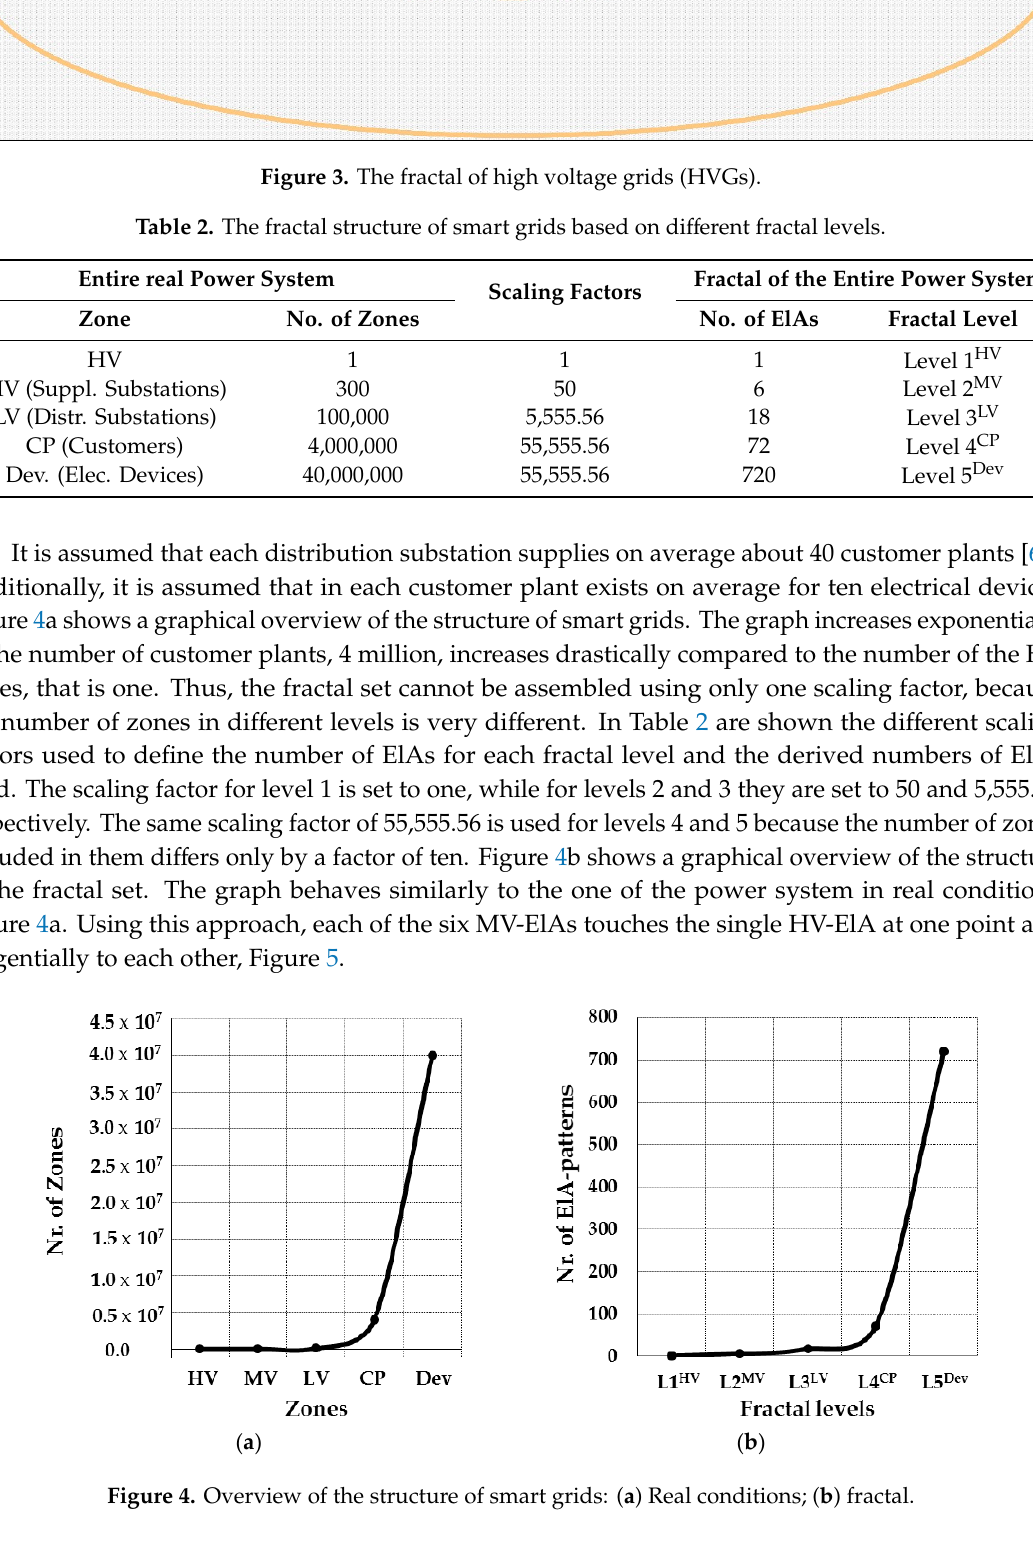
Figure 5. The fractal set of HV and medium voltage graphs (MVGs). The latter symbolizes the tie switches (normally open points) connecting feeders of different MV-subsystems. For the 18 LV-ElAs is used the same principle as for MV-ElAs, Figure 6. Figure 6. The fractal set of HV, MV and low voltage graphs (LVGs). Four CP-ElAs are added into every LV-ElA, each touching only one point of the LV-ElA pattern (every customer plant has one electrical connection point with the LV grid and no connection with each other), Figure 7.